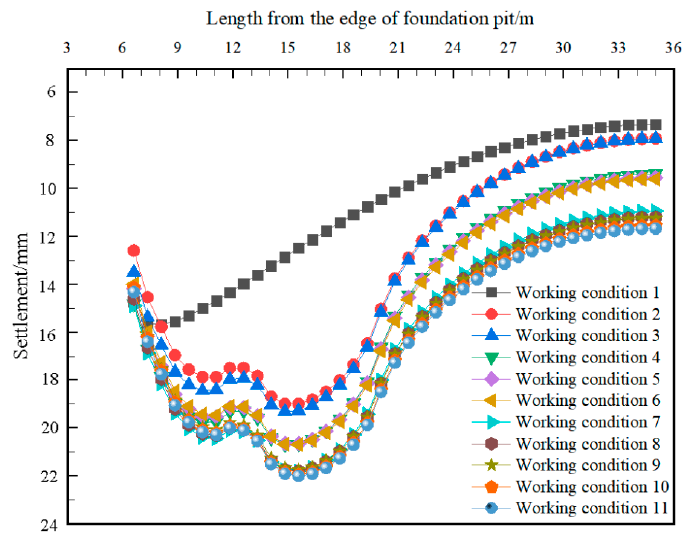
15 of 20 Figure 18. Initial pore water pressure distribution. Figure 19. Final pore water pressure distribution. The surface settlement around the foundation pit under different working conditions is shown in Figure 20. Working Conditions 4 and 7 show that the dewatering process of the foundation pit increased the surface settlement near the edge of the foundation pit, and the influence effect was up to 23 mm. Due to the Mohr–Coulomb constitutive model,